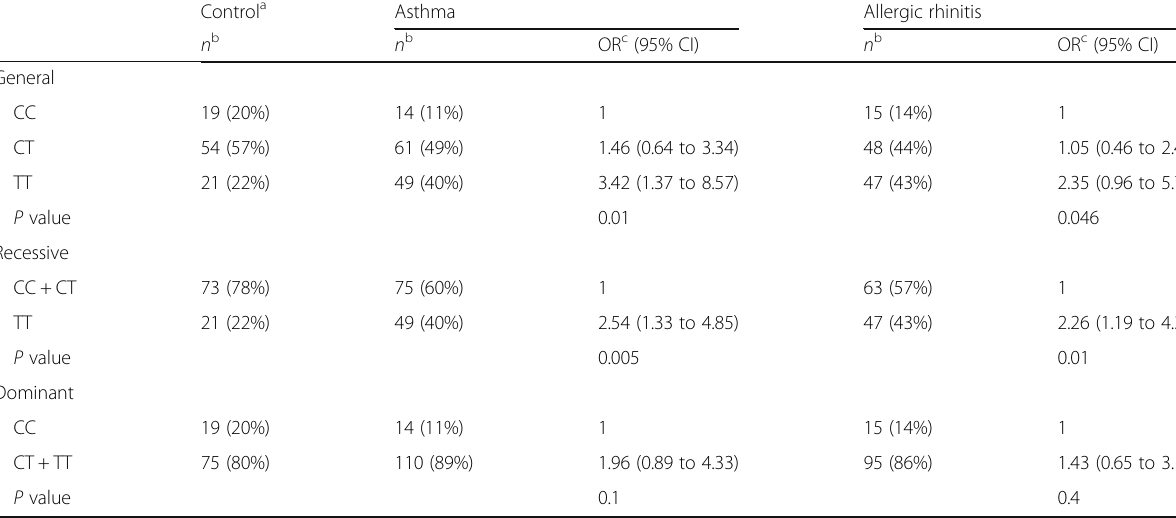
Table 2 Case – control genotype data analysis